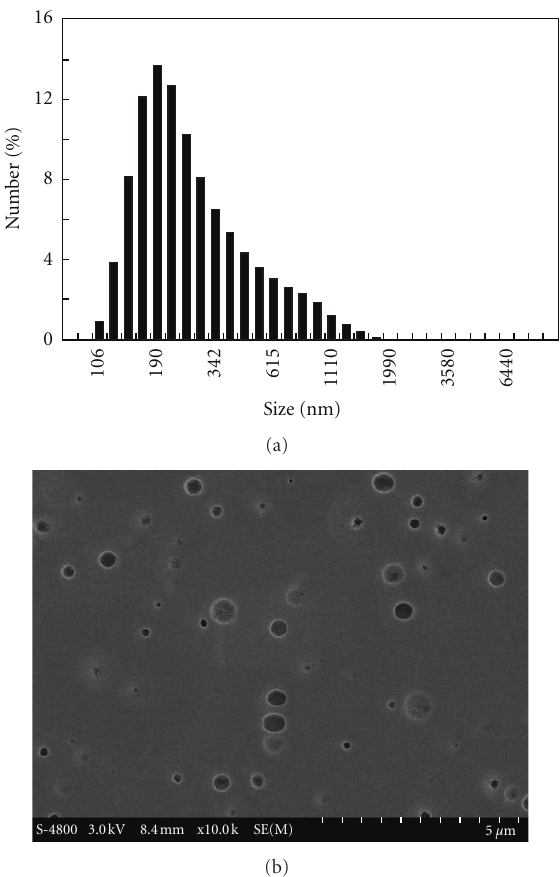
Figure 1: DLS histogram and SEM image of PLLA nanoparticles.